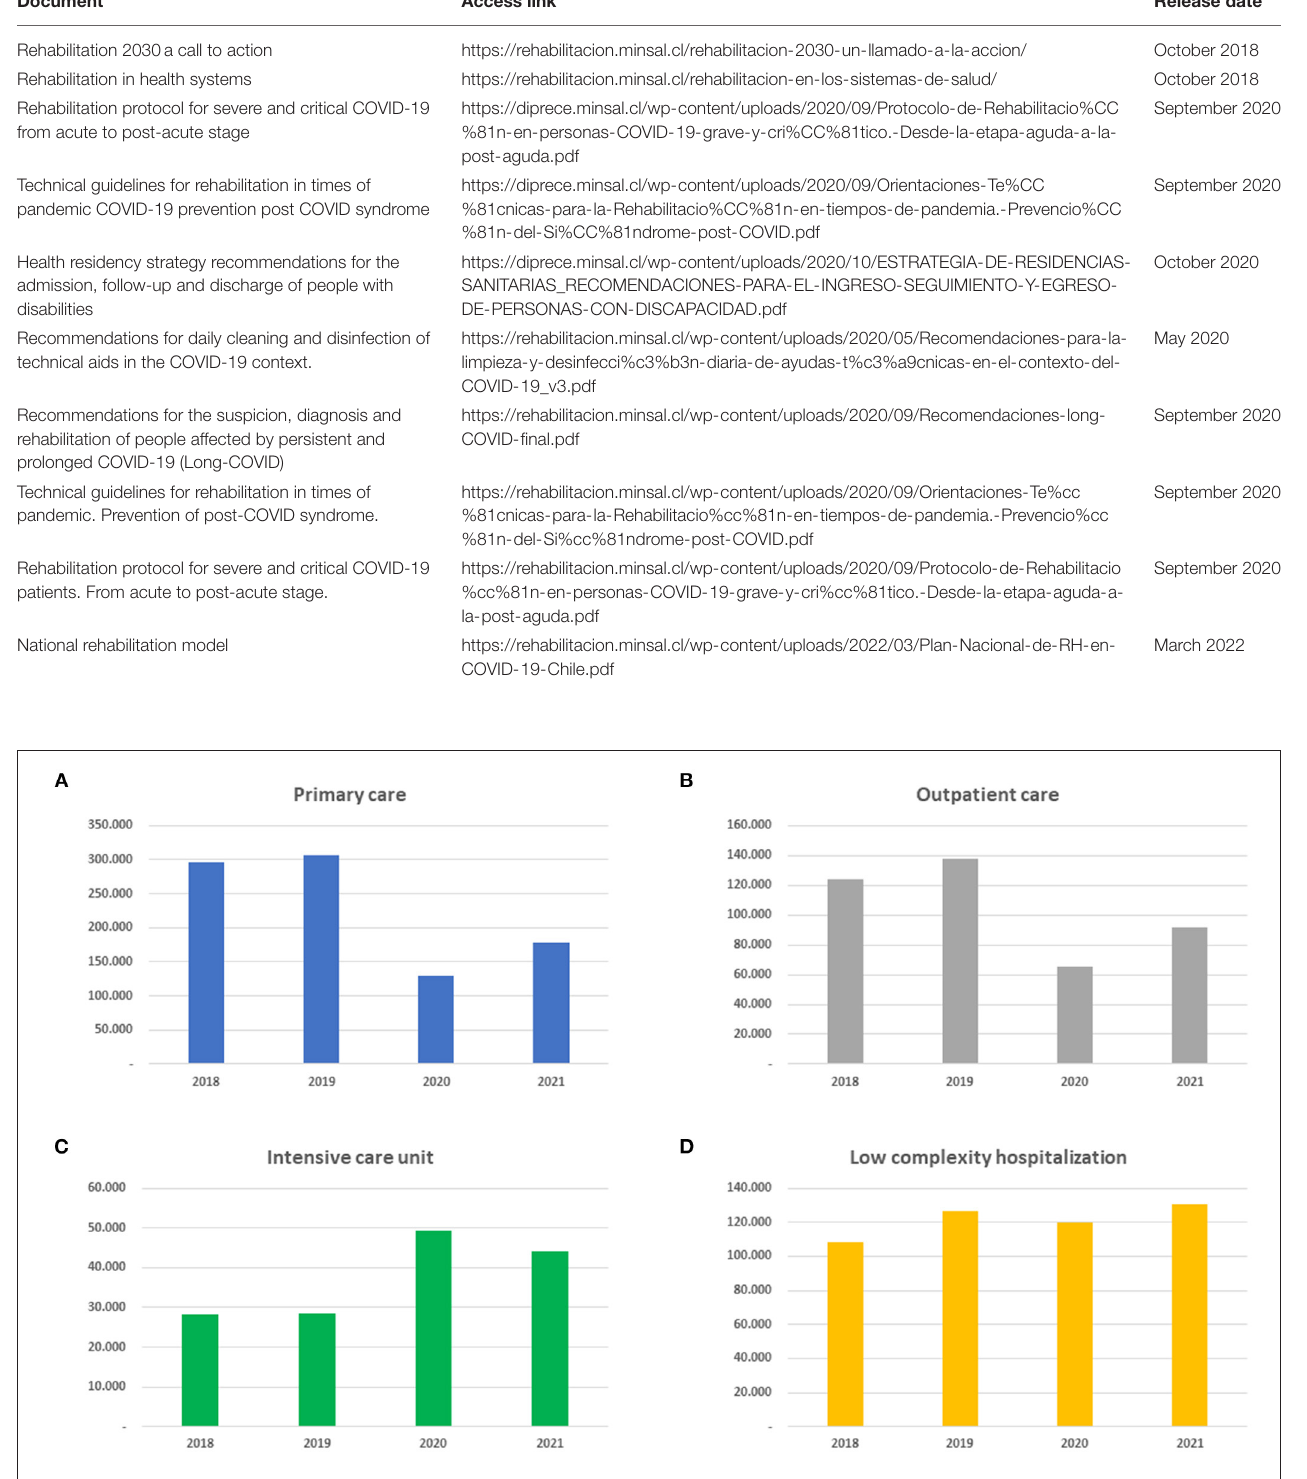
FIGURE 2 | (A–D) Admission of patients according to level of